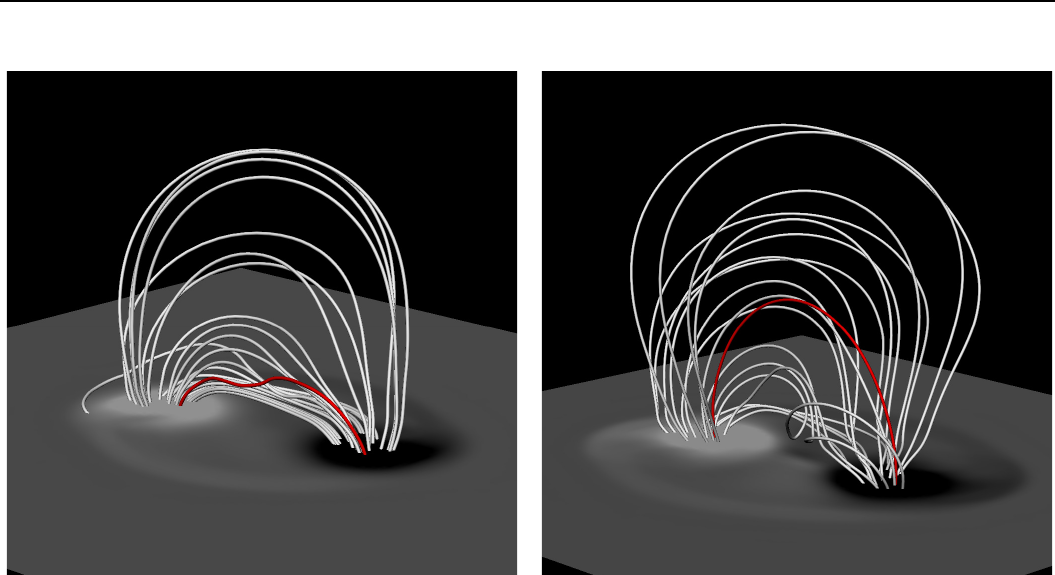
Figure 44: Magnetic fields in the simulations of the emergence of toroidal flux tube from MacTaggart and Hood (2009b), with weaker field (left) and stronger field (right). The red line in each panel indicates the axial field line. The grey horizontal slice shows the distribution of vertical magnetic field in the photosphere. In the stronger field case (right), twisted field lines above the photospheric layer yield a flux rope-like structure. Images reproduced with permission, copyright by